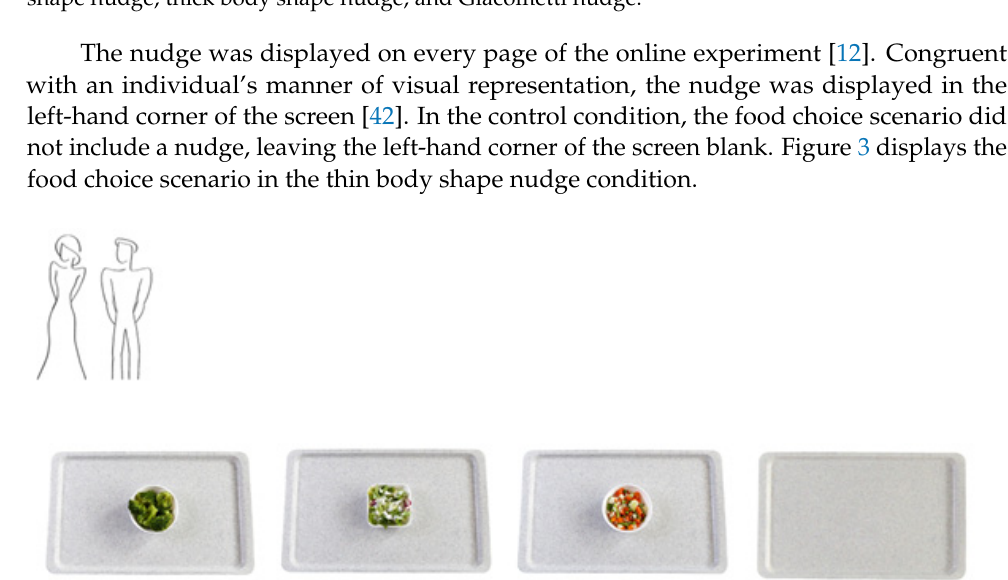
Figure 2. Nudges are shown in the different experimental conditions—from left to right, thin body shape nudge, thick body shape nudge, and Giacometti nudge.